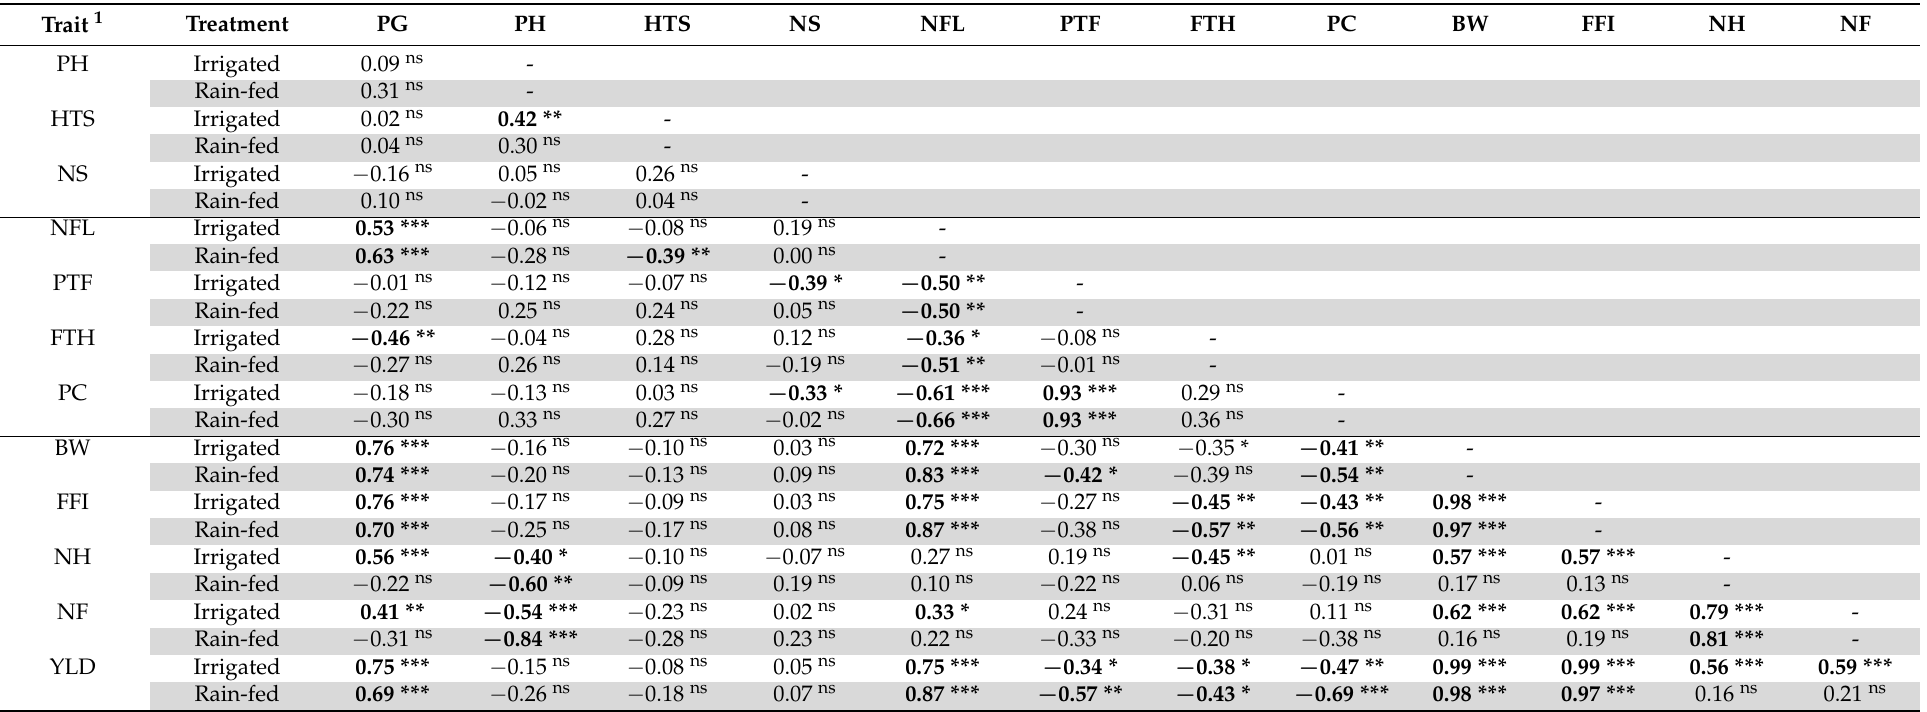
Table 3. Pearson’s correlations among the agronomic traits evaluated under irrigated and rain-fed treatments in the first crop